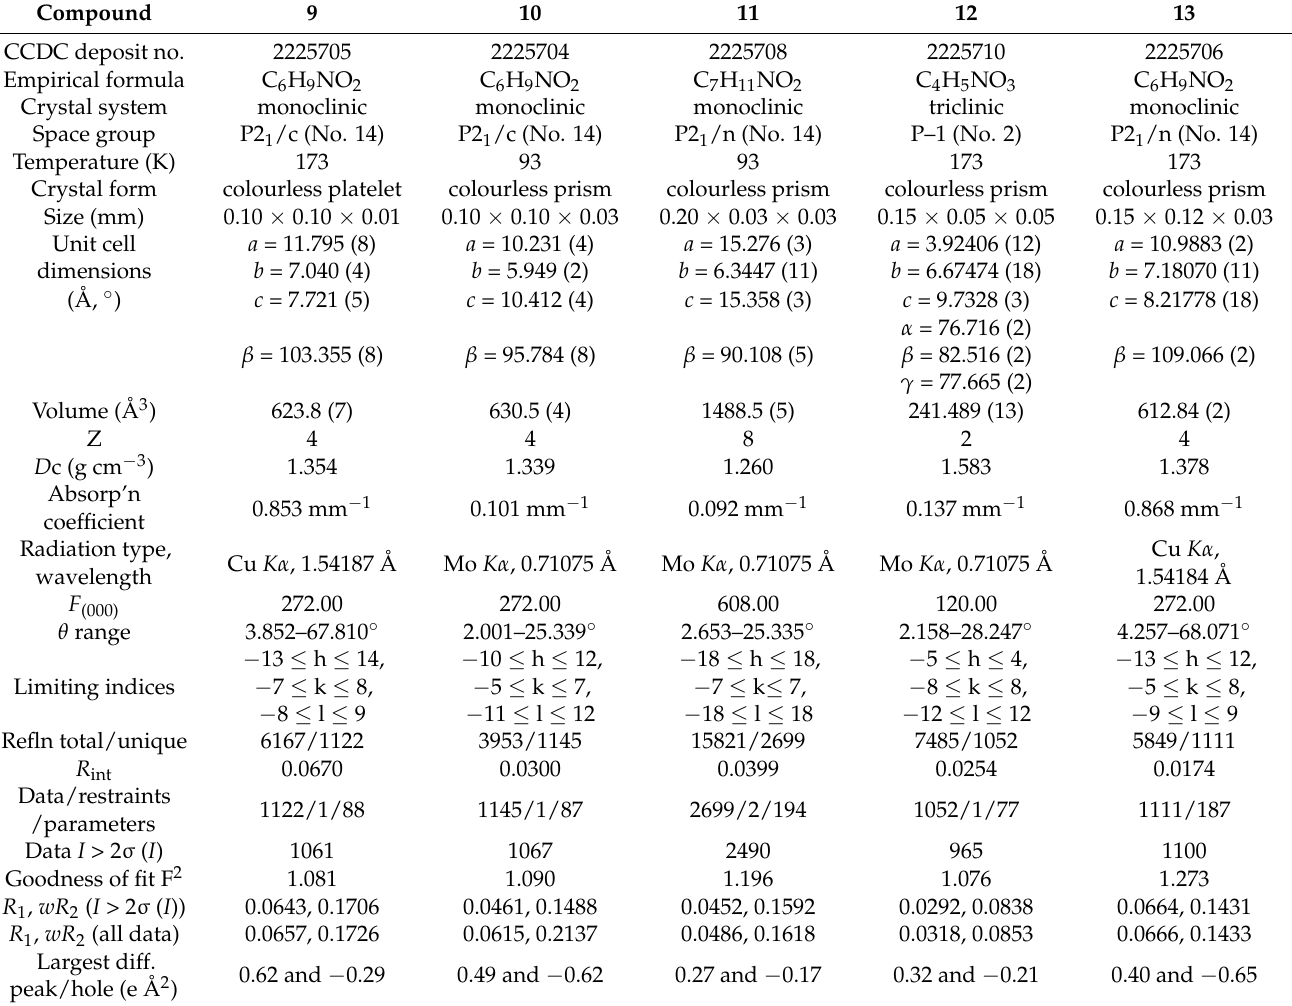
Table 3. Summary of crystallographic data obtained for compounds 9–13